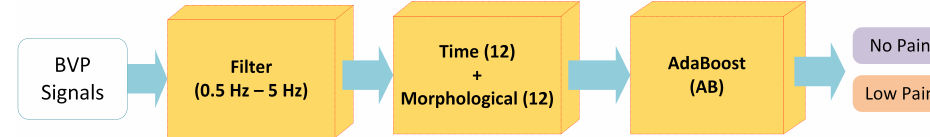
Figure 9. The proposed methodology for Experiment 2 (no pain vs. low